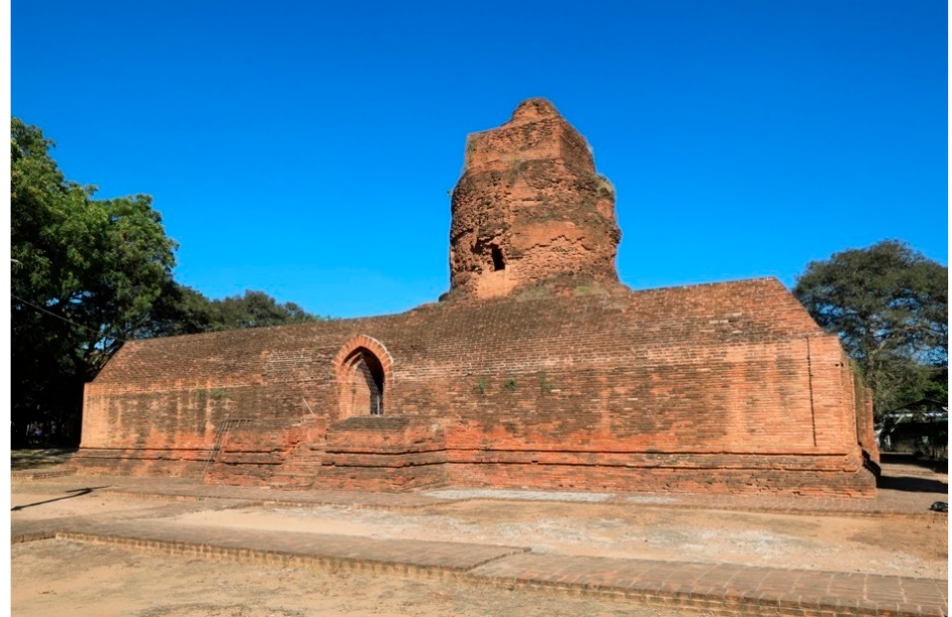
Figure 32. Pagan, Hpetleik Stupa, 11th century. Several hell images survive at the entrance to an encircling corridor featuring jataka plaques on both sides. Religions 2020 , 11 , x FOR PEER REVIEW